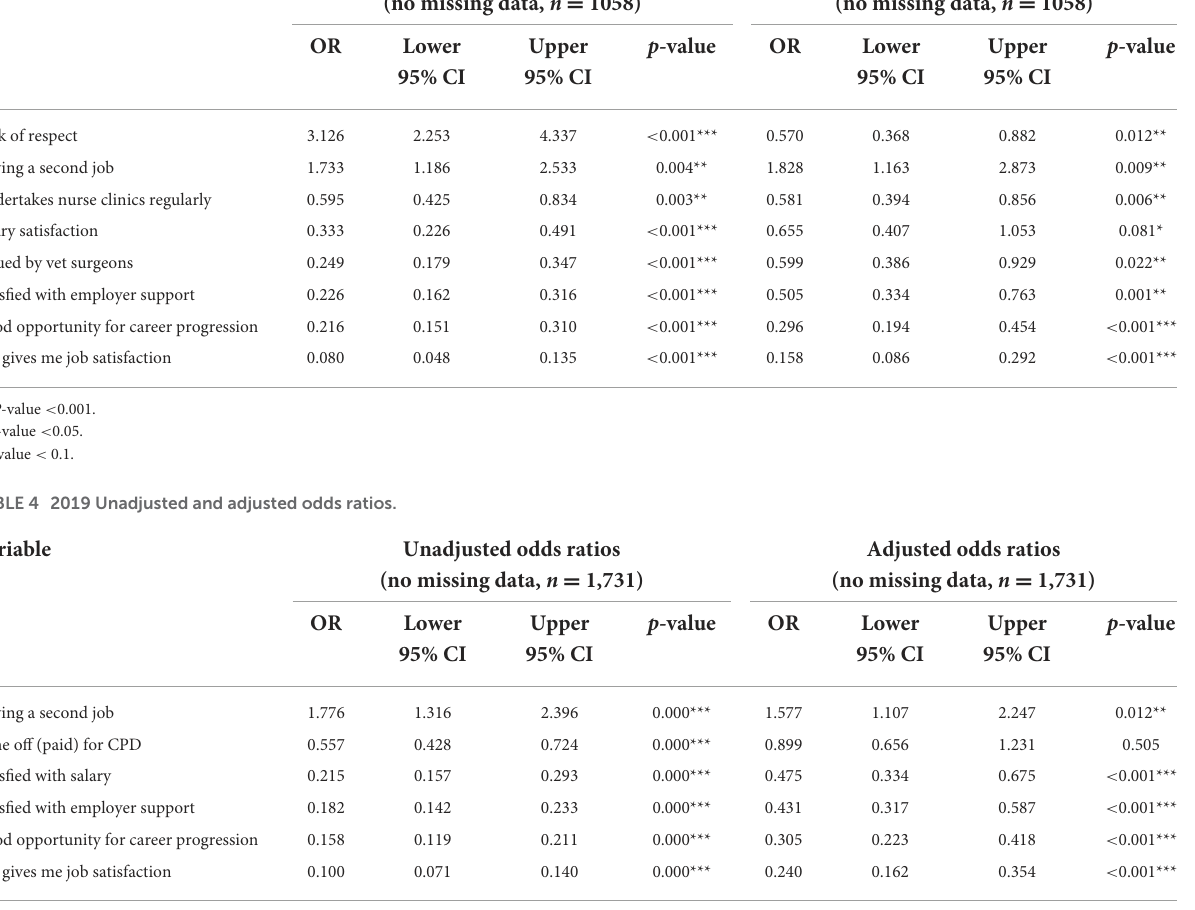
TABLE 3 2014 Unadjusted and adjusted odds ratios. Variable